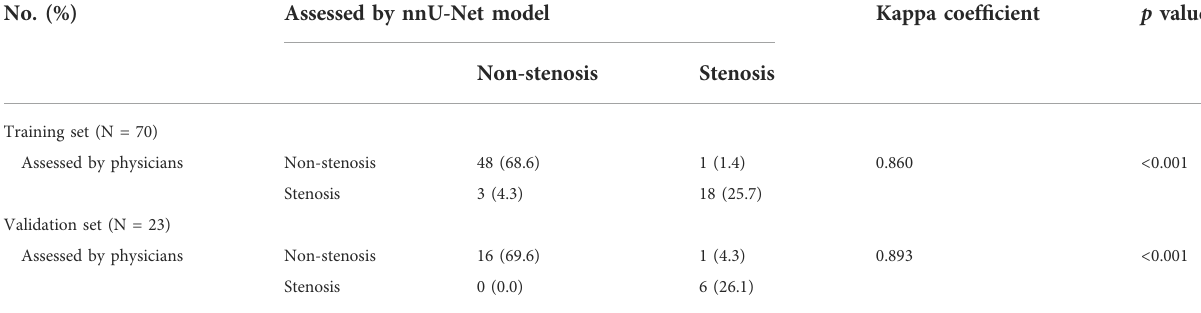
TABLE 3 Consistency between nnU-Net model and physicians in evaluating carotid artery stenosis in training and validation sets. No.